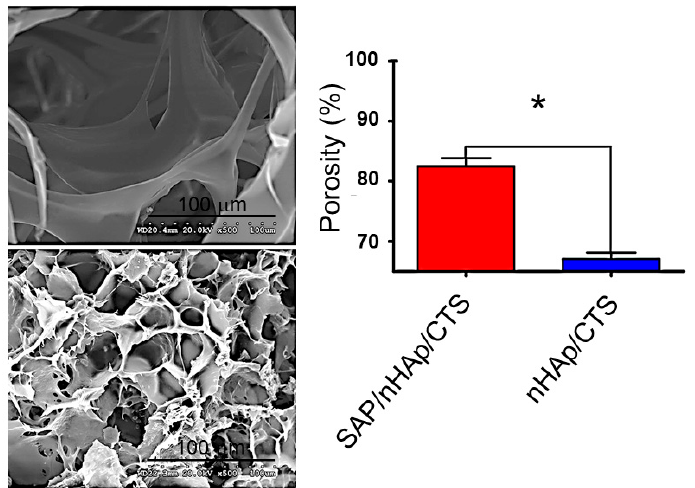
Figure 10. The morphology and SEM of ( top left ) nHAp/ CTS and ( bottom left ) SAP/nHAp/CTS. ( right ) The porosity of the SAP/nHAp/CTS was 84.53%, which was significantly higher than that of nHAp/CTS, 67.97%, * p < 0.05. Reproduced from [144]. CTS: chitosan; SAP: self-assembled peptides.